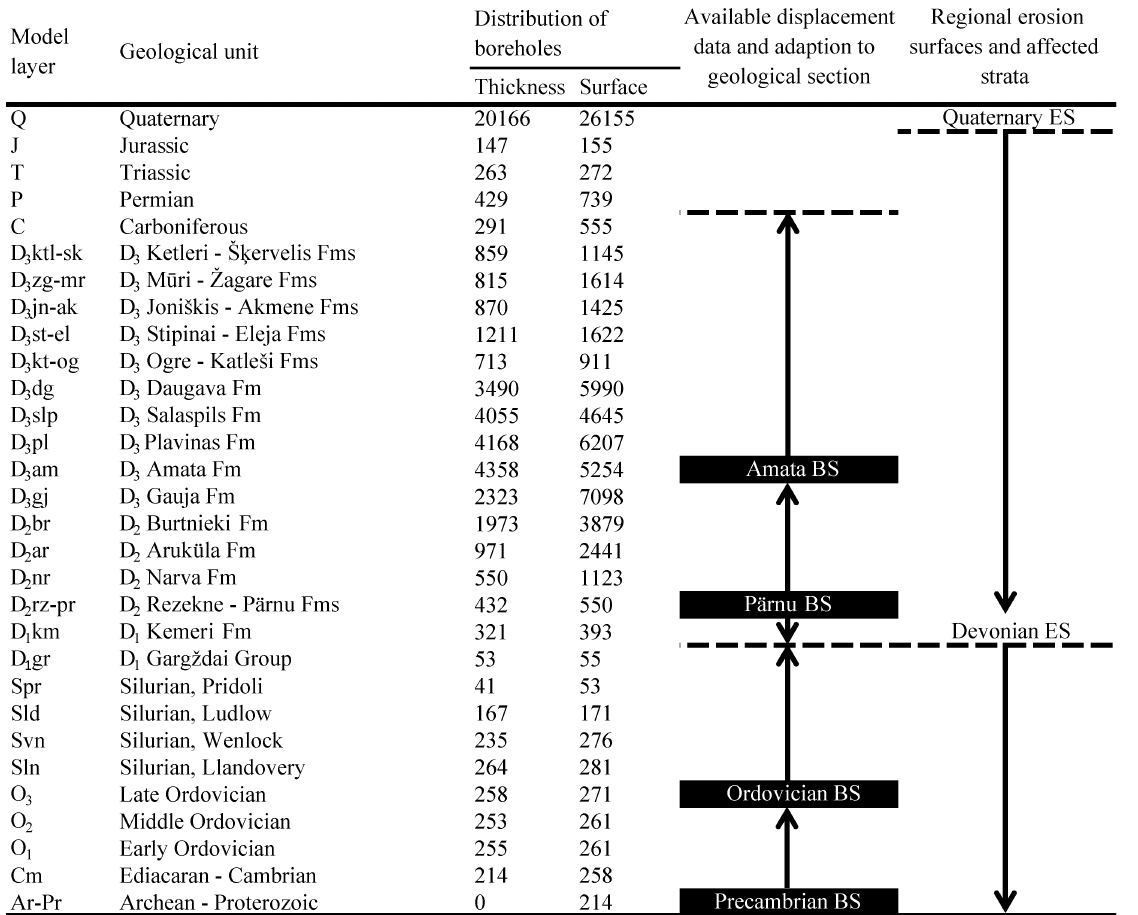
Fig. 4. Stratigraphic and structural concept of the model structure, available borehole and structural data. The 4th column denotes the layers with available displacement; the arrows show the adaptation of the displacement to other layers. The 5th column represents regional erosion surfaces; the arrows show the influence on the geological section. BS, base surfaces; ES, erosion